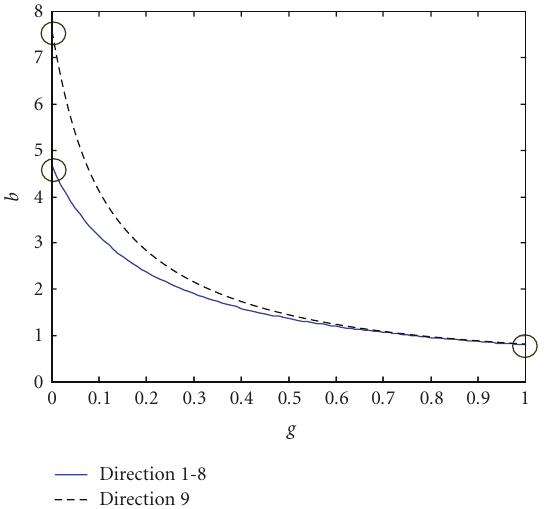
Figure 6: b versus g for the direction 1–8 (solid blue line) and direction 9 (dashed line) the black circles represent the g = 0 / 1 cases and the equivalent b